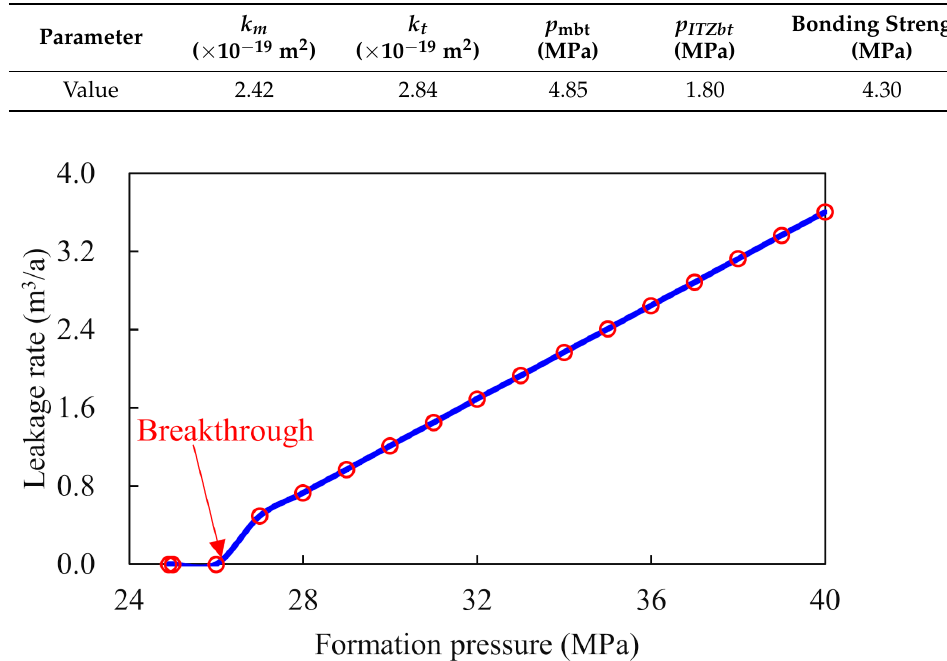
Table 4. Performance parameter of expansive-elastic cement.